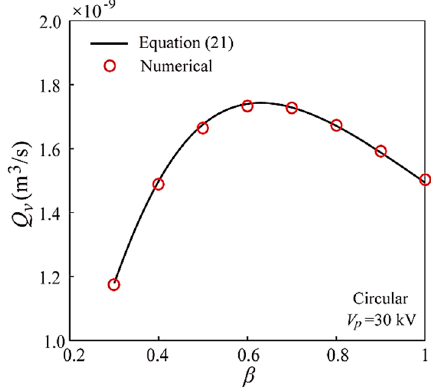
Figure 7. Effect of daughter-to-parent channel diameter ratio on the flowrate of EOF in the Y-shaped circular microchannels.